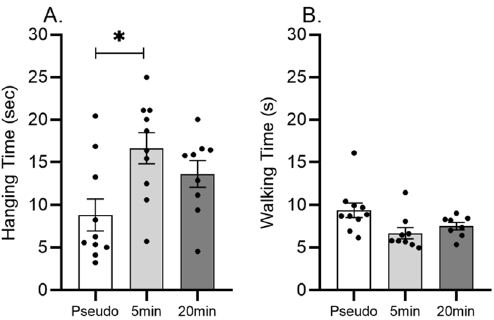
Figure 5. Effects of 5 and 20 min daily sessions of WBV on muscle strength in grip hanging test (panel A) and motor coordination in balance beam test (panel B ). Data are depicted as mean ± SEM. * indicates P < .05.